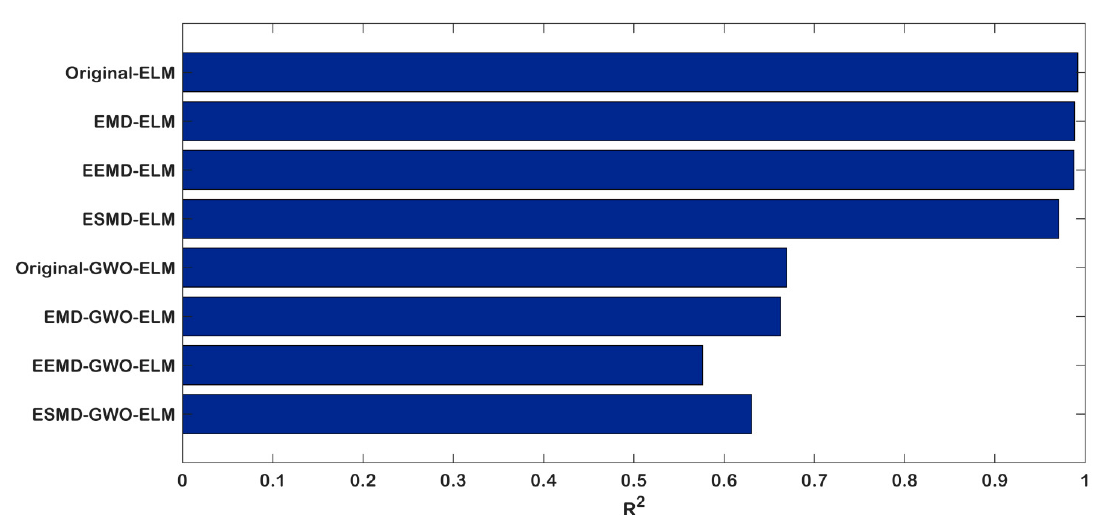
Figure 14. The values of the R 2 parallel models.